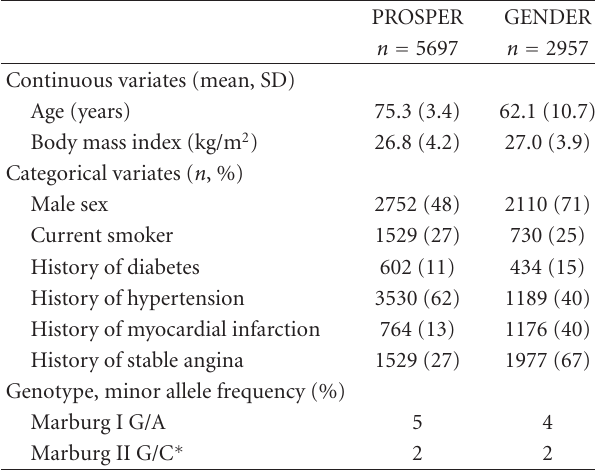
Table 1: Baseline characteristics of the PROSPER and the GENDER study in patients with Marburg I genotype.